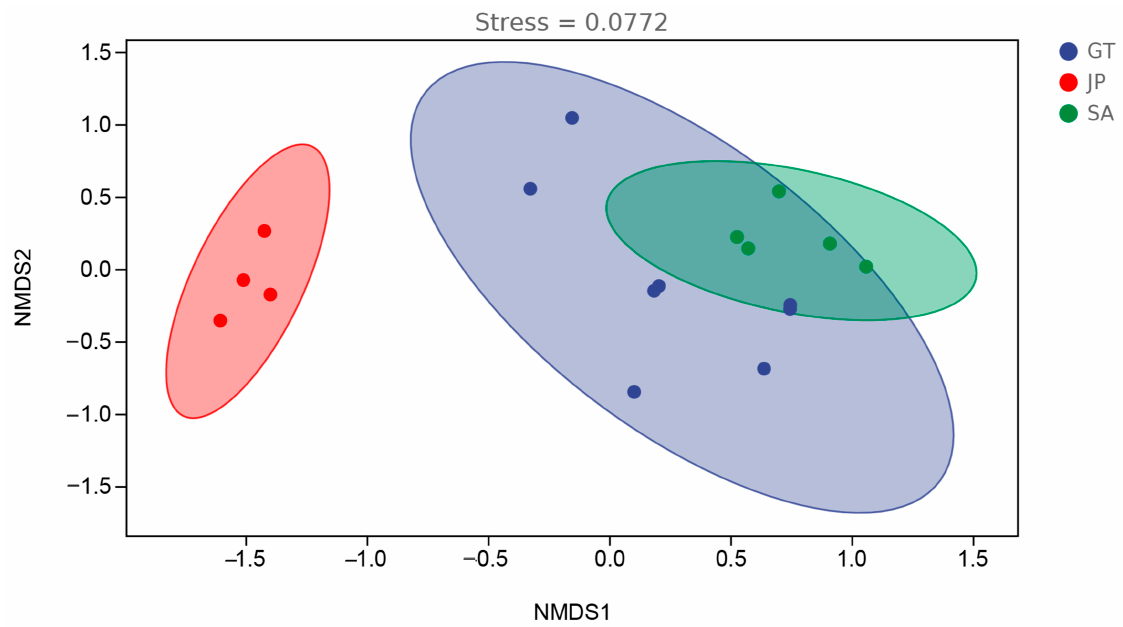
Figure 4. Visualization of the distribution characteristics of samples from bare flats (GT), Sueada salsa areas (JP), and S. alterniflora Loisel areas (SA) (confidence interval ≥ 0.95). Table 2. Anosim was used to verify difference between bare flats (GT), Sueada salsa areas (JP), and S. alterniflora Loisel areas (SA).